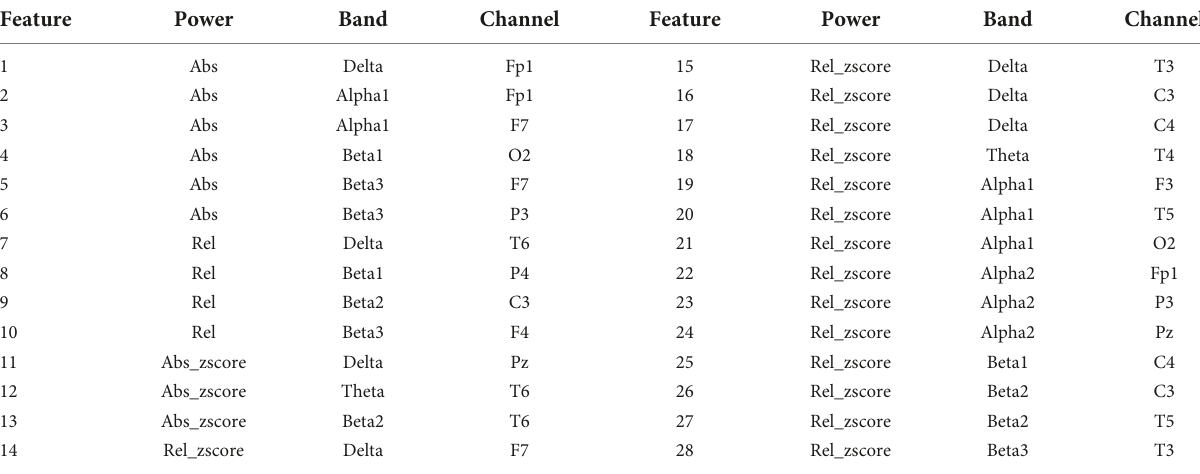
TABLE 4 Information of 28 features used in a AdaboostM1